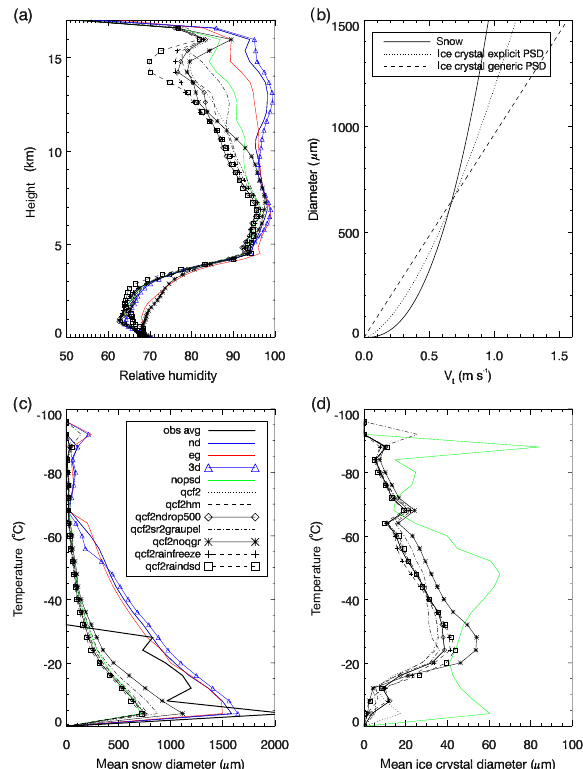
Figure 4. (a) Simulated relative humidity is for the area encom- passed by the 150km radius centred on the Darwin radar on 18 February 2014 from 23:00 to 24:00UTC. (b) Ice fall speeds (ms − 1 ) as a function of diameter (µm) for the snow category and the ice crystals used in the simulations with the explicit and generic PSD, see text for details. (c) Mean mass-weighted snow diameter (µm) as a function of temperature ( ◦ C) where the observations are from the aircraft and have been averaged to be representative of a 1km 2 grid cell. (d) As for (c) except for the mean mass-weighted ice crystal diameter